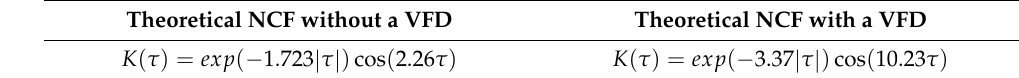
Table 7. Theoretical NCFs. Table 8. Theoretical NCFs.